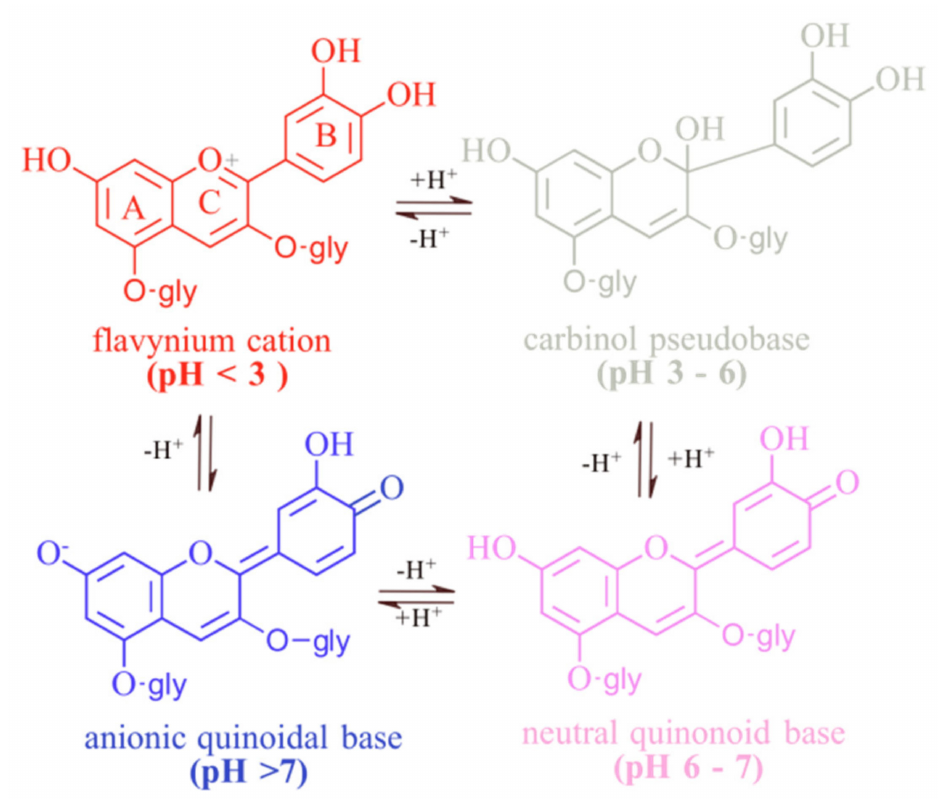
Figure 4. Chemical and color modifications of ANs in different pH value environments. The most representative and common form of ANs, the red-colored flavylium cation, is present at acidic pH. Marquez and coworkers [38] tested three different temperature options while extract- ing ANs through controlled dehydration of Tempranillo red grapes: 30 ◦ C, 40 ◦ C, and at alternations between 40 ◦ C and 15 ◦ C, every 12 h. The best results were obtained in the second experiment; the grapes dried at 40 ◦ C had the most intense color, which indicates the highest concentration of ANs. The must obtained at 30 ◦ C still contained significant amounts of ANs but displayed a slight brown color. The least satisfactory result was obtained in the final experiment because the reduction in the temperature value allowed oxygen to diffuse through the grape skin and caused degradation reactions of ANs and loss of the red color